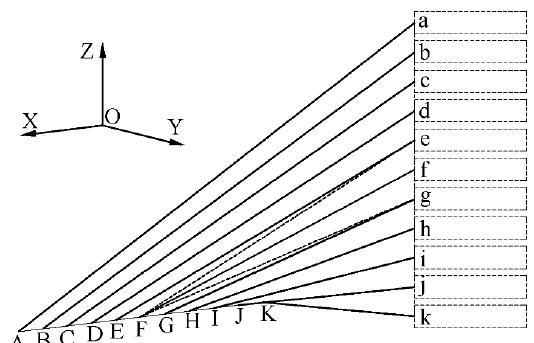
Figure 4. Model of a sequence of a one-dimensional (1-D) to 1-D form.